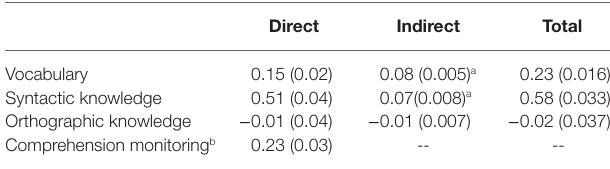
TABLE 2 | Direct, indirect, and total effect estimates of the model predictors on Grade 1 reading comprehension. Direct Indirect